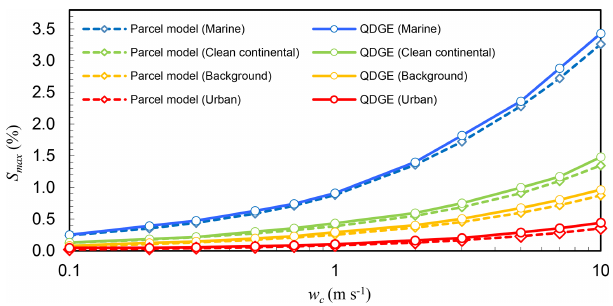
Figure 3. Comparison between the calculated maximum supersat- uration ( S max ) from the QDGE scheme (solid line) and the parcel model (dashed line, Ghan et al.,